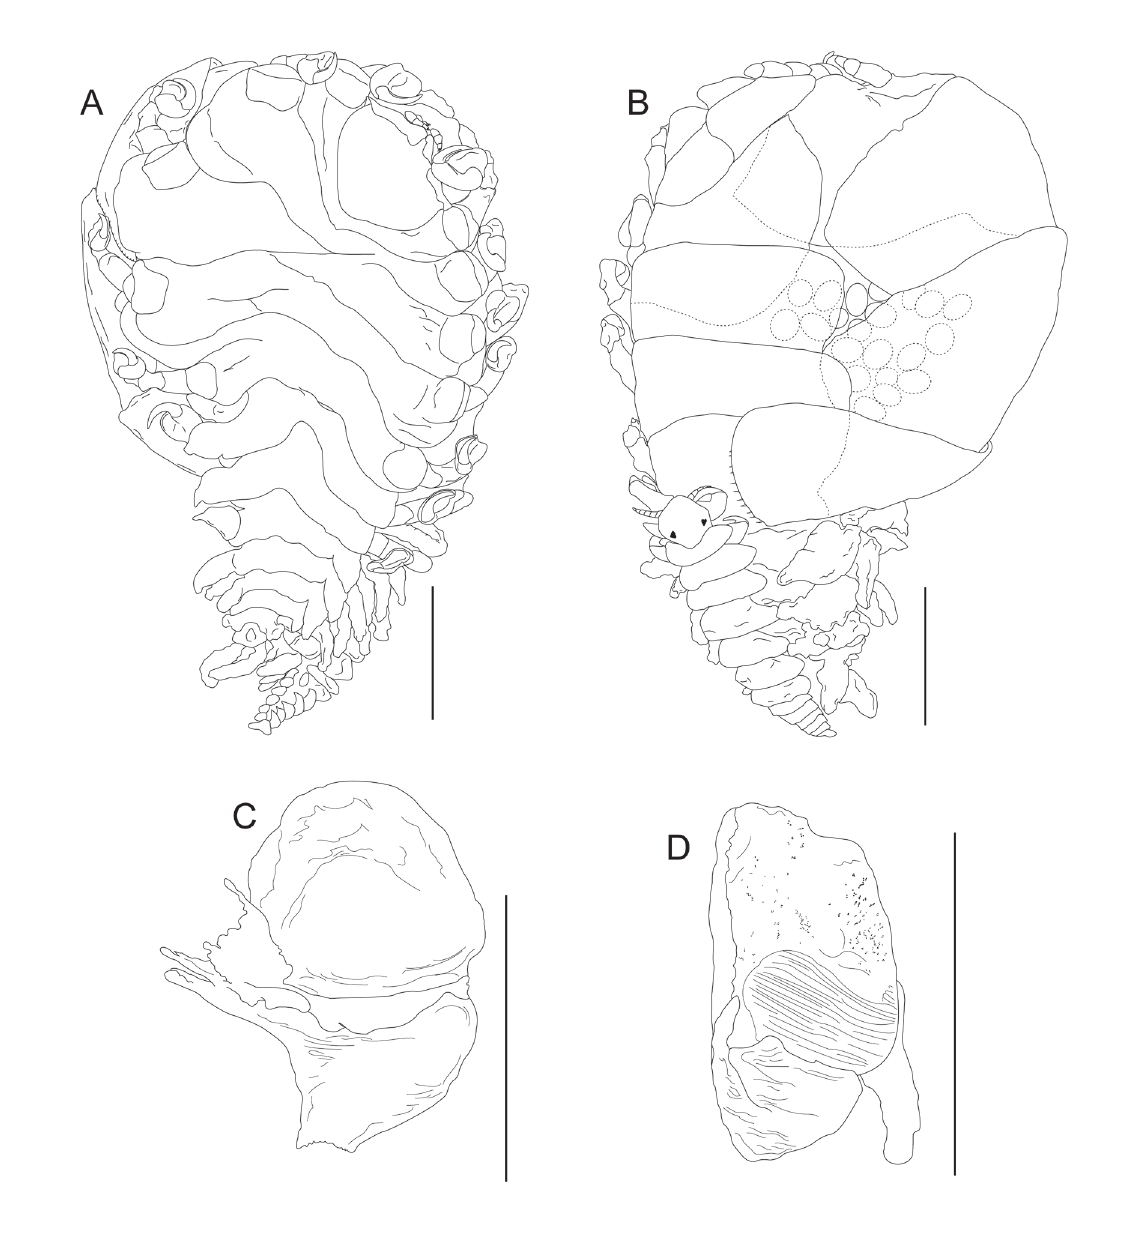
Fig. 6. Asymmetrione desultor Markham, 1975 (CNCR-36488). A . Ovigerous ♀, dorsal view. B . Same, with ♂ attached to pleon, ventral view. C . First oostegite, internal view, posterolateral point damaged. D . Maxilliped, with lateral projection of barbula. Scale bars =